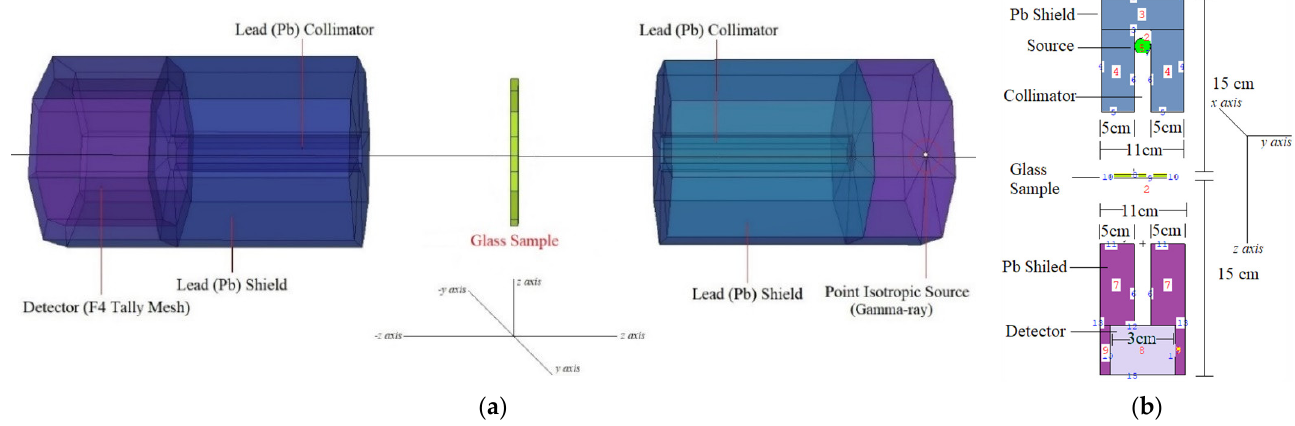
Figure 1. MCNPX setup: ( a ) 3D view of gamma-ray transmission setup obtained from MCNPX Visual Editor; ( b ) 2D view of gamma-ray transmission setup with dimensional information obtained from MCNPX Visual Editor.